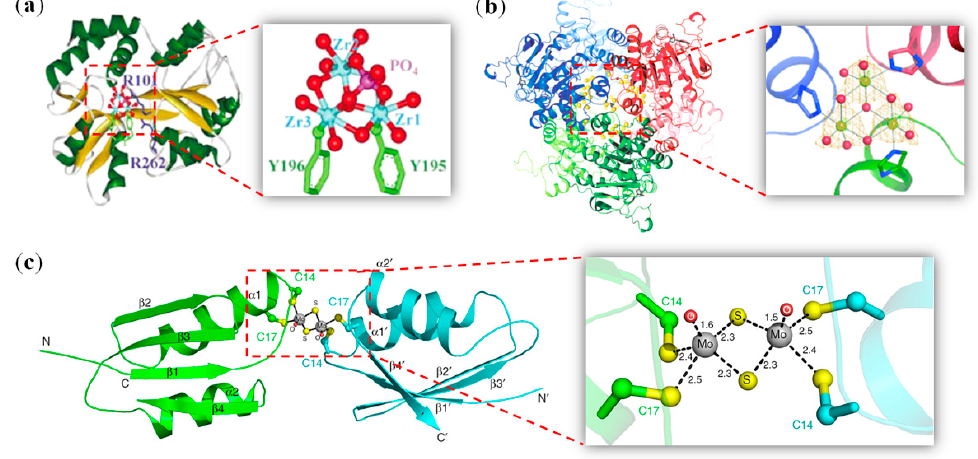
Figure 5. ( a ) X-ray structure of Zr 3 –nFbp showing the coordination geometry. Reprinted with